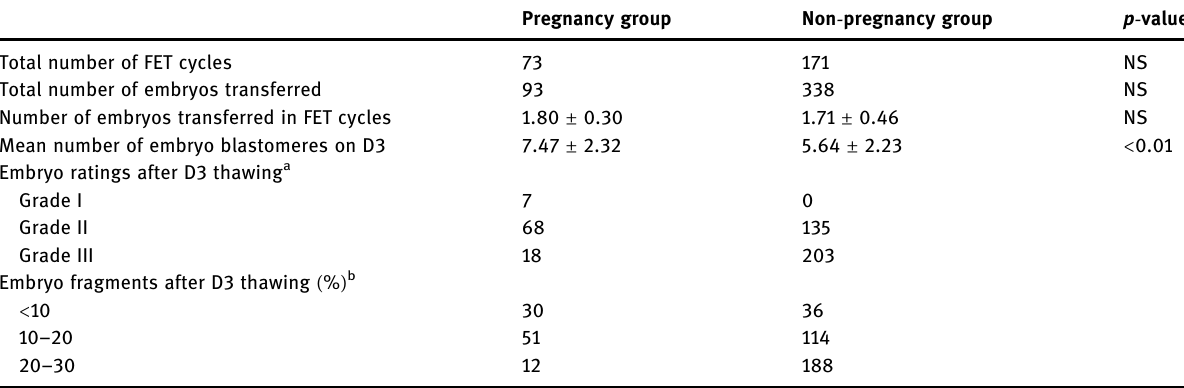
Pregnancy group